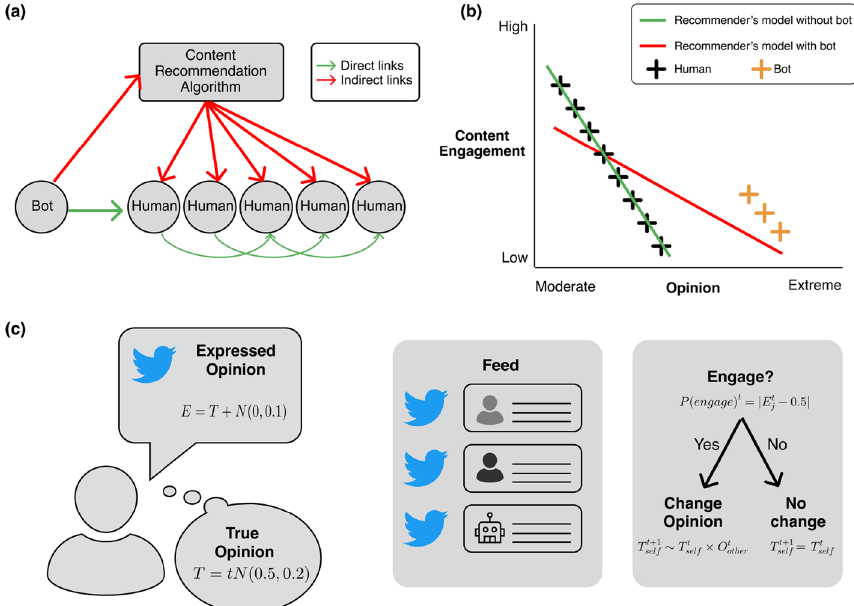
Fig. 1 The indirect influence of bots on social information networks. (a) Representation of opinion dynamics network mediated by a content recommender system (grey box on top). Bot and Human agents (circles) consume and share content. A bot agent can influence human opinions via direct interaction with human agents (e.g., retweets, at-mentions, likes, and comments) or indirectly via affecting the internal representation of the content recommendation algorithm. (b) Schematic representation of the effect of bot presence on the internal representation learned by a simple recommender system trained to predict a user’s engagement with various types of content. Including the bot behavior in the training set skews the model to think that engagement with extreme content is more likely than it would be without the bot presence. (c) Agents in the simulation were modeled to include a true private opinion and an expressed public opinion. Agents were presented with one of their neighbors’ public opinions on every round based on the recommender’s predicted content engagement. Then the agents decided whether to engage with this content or not according to their engagement function (Eq. 3). Opinion change took place only if the agent decided